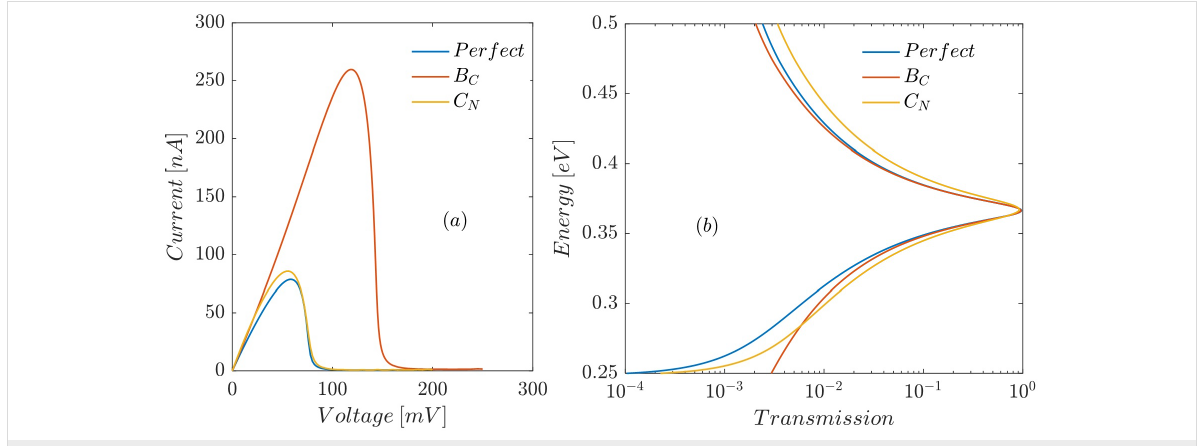
Figure 7: Effect of B C and C N defects at the interface between the left barrier and the left spacer on (a) current–voltage characteristic and (b) the transmission trough the proposed RTD as a function of the electron energy.